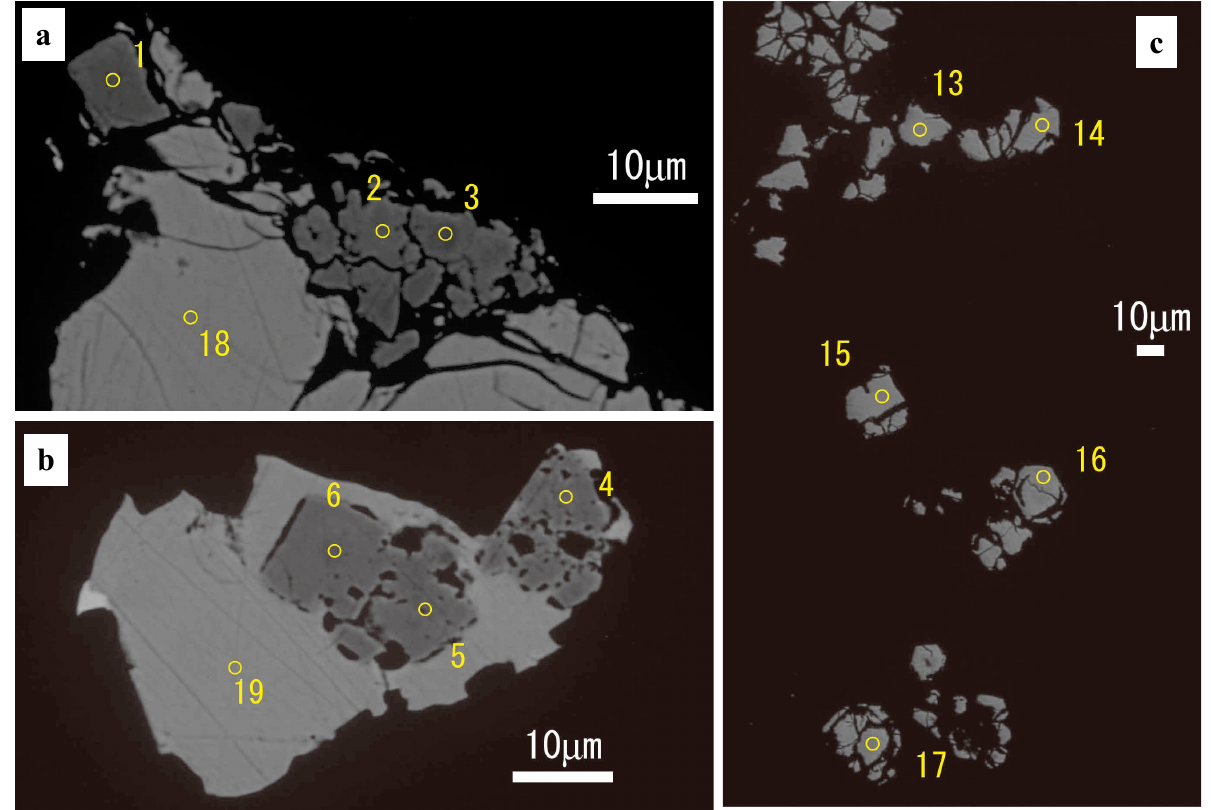
Figure 5. BSE images of pyrite and chalcopyrite grains from the Zuisen No. 1 vein (sample name 98121705 in Table 5) of the Hishikari ore deposit. ( a ) The analysis spot 1-1 (pyrite grain 1) and analysis spot 1-18 (chalcopyrite grain 18) are shown. ( b ) The analysis spots 2-4 and 2-6 (pyrite grains 4 and 6) and analysis spot 2-19 (chalcopyrite grain 19) are shown. ( c ) The analysis spots 4-13 and 4-15 (pyrite grains 13 and 15) are shown. Most pyrite grains are fine.